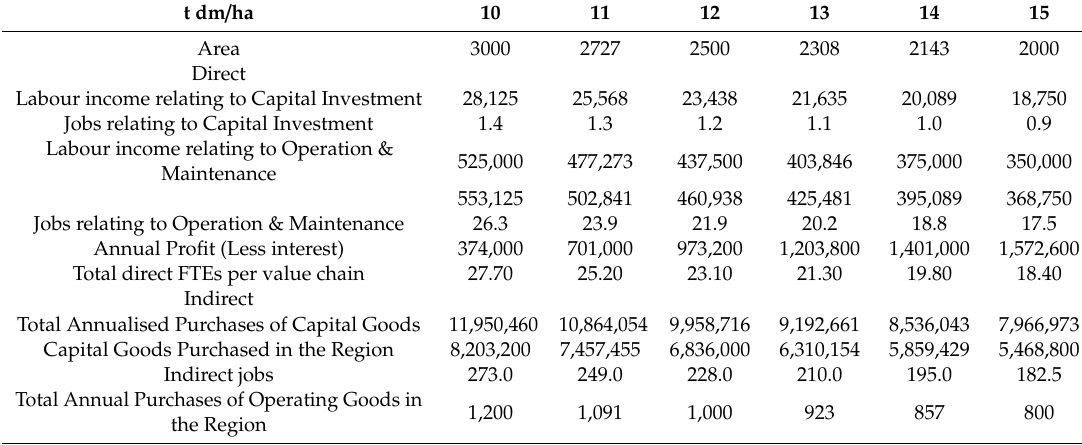
Table A7. Net impacts from the cultivation of Miscanthus for Fast Pyrolysis Biomass Oil; 20,000 tonnes /